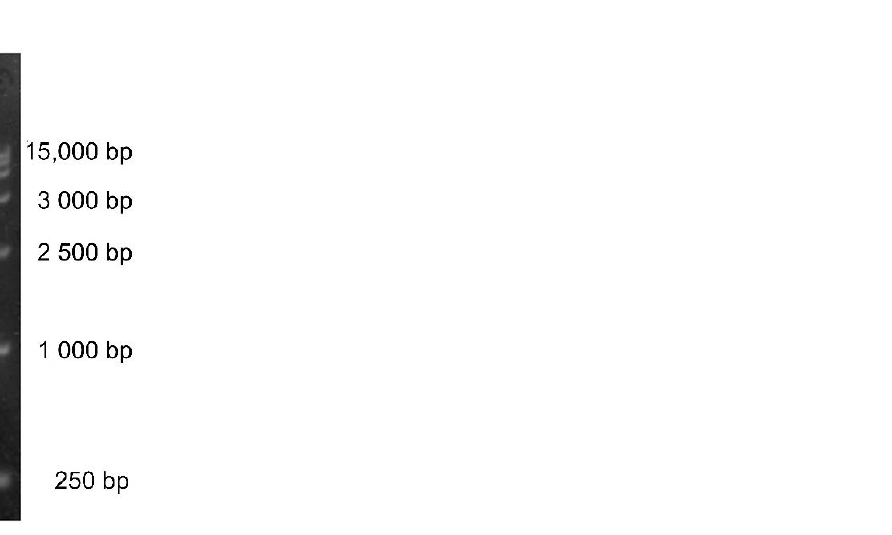
Figure 2. Validation of yshyl8A recombinant sequences: 1, Digestion validation results; M, 15000 DNA Marker.